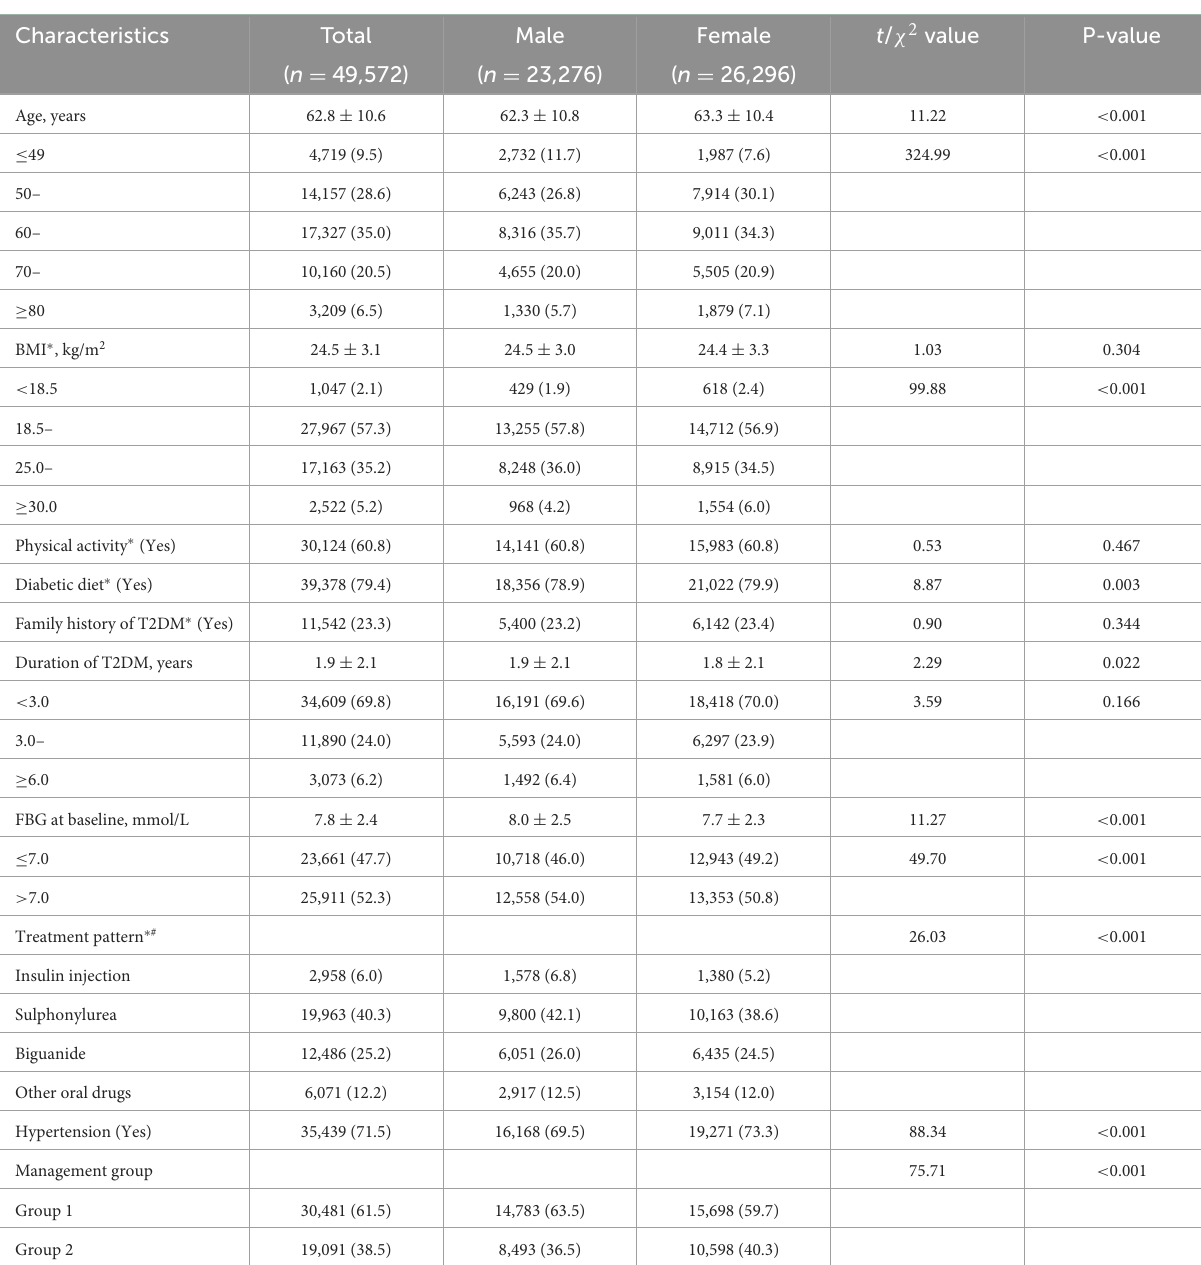
TABLE 1 Baseline characteristics of